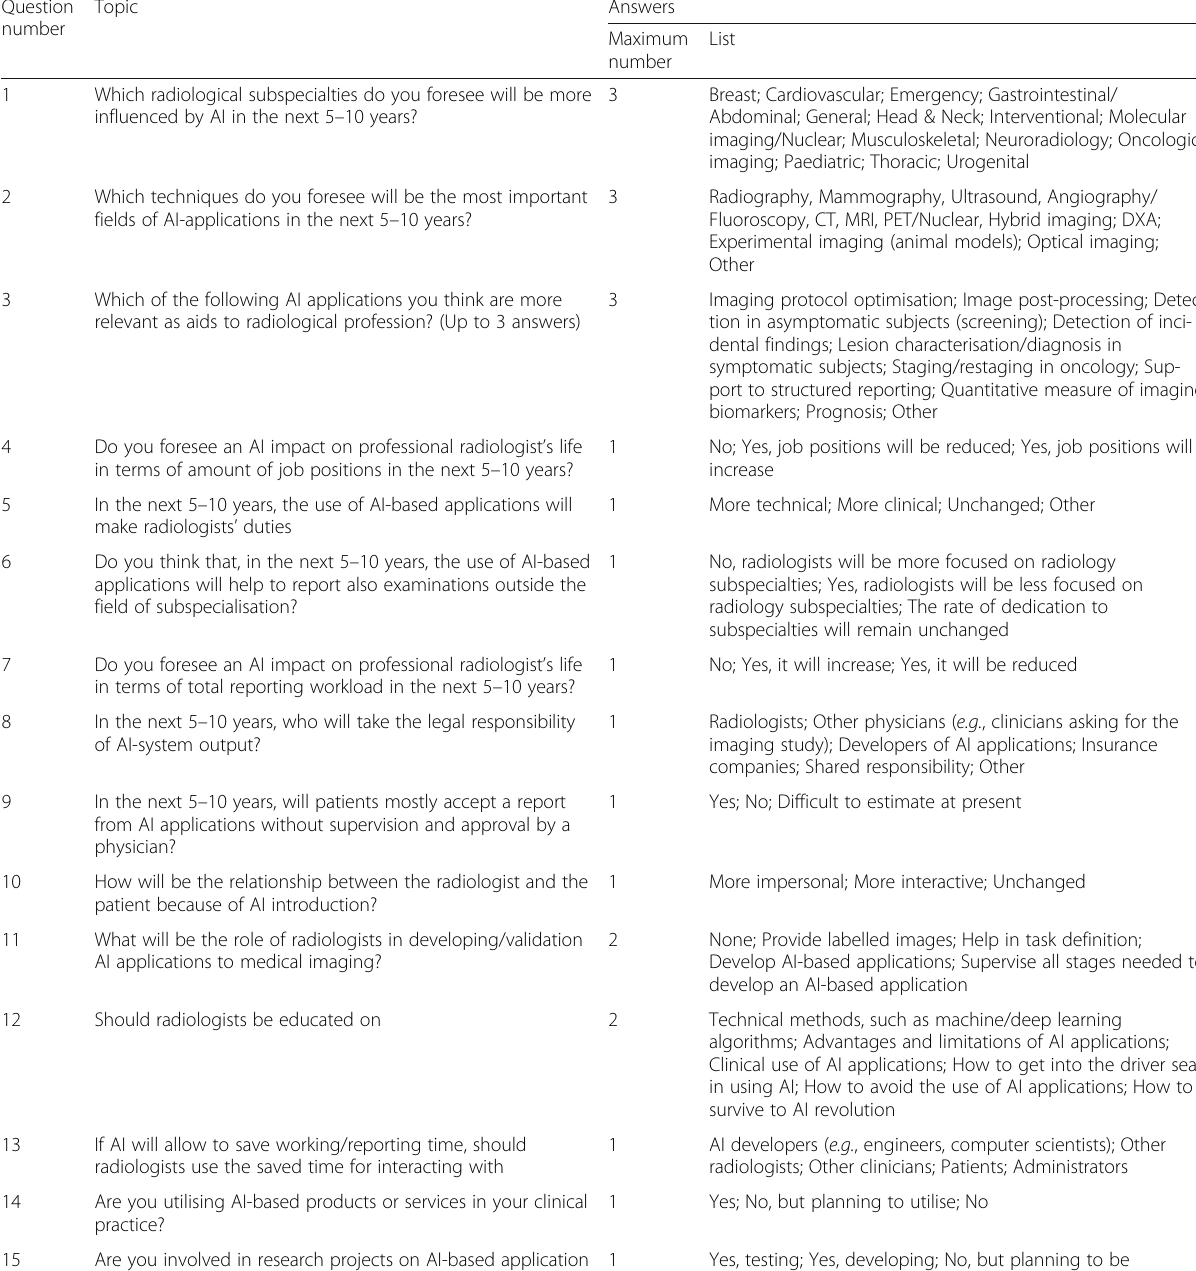
Table 2 Multiple-choice questions about user feelings/forecasts in respect to the advent of artificial intelligence (AI) applications in radiological practice in the next 5 – 10 years Question